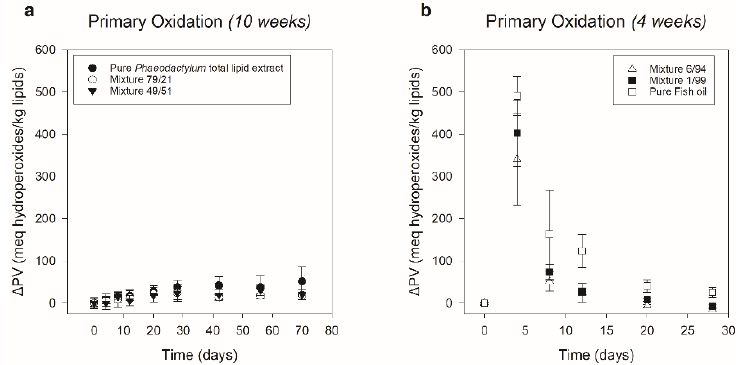
Figure 4 . Primary oxidation of six different ‘Phaeodactylum total lipid extract–fish oil’ systems during storage at 37 °C. ‘Pure Phaeodactylum total lipid extract’, ‘Mixture 79/21 ′ and ‘Mixture 49/51 ′ (respectively possessing 100.0%, 78.6% and 49.2% ( w / w ) of Phaeodactylum total lipid extract) were stored for 10 weeks ( a ). ‘Mixture 6/94 ′ , ‘Mixture 1/99 ′ , and ‘Pure Fish oil’ (respectively possessing 6.4%, 0.7% and 0.0% ( w / w ) of Phaeodactylum total lipid extract) were stored for 4 weeks ( b ). The peroxide values (mean ± sd, n = 3) are expressed as delta values, representing the relative increase or decrease compared to day zero. Information on statistical significance can be found in Supplementary Materials (Table S3).